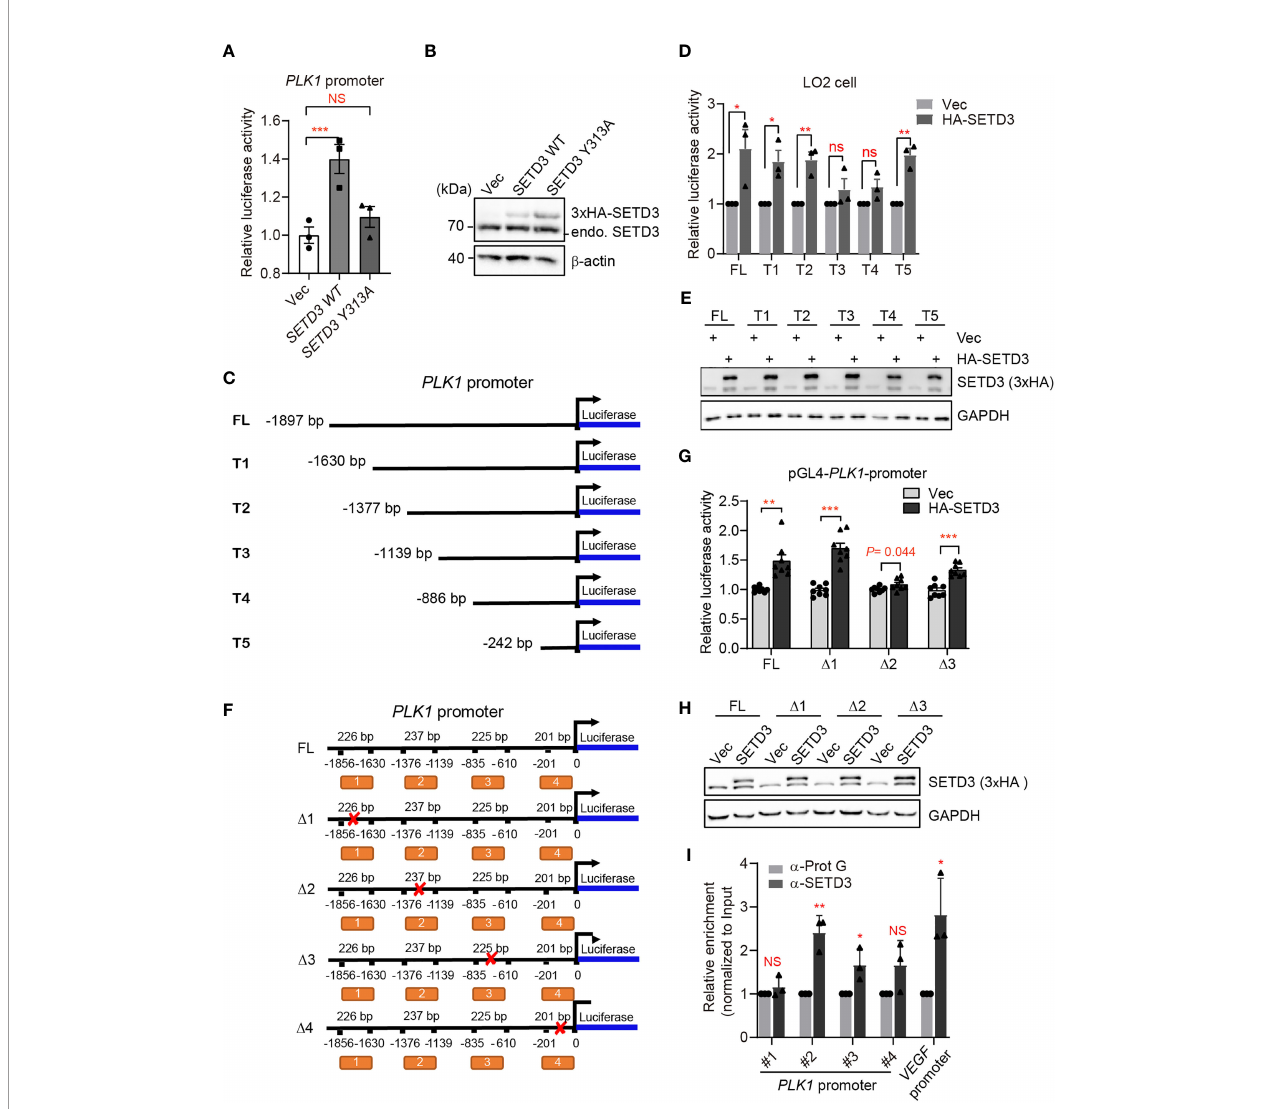
FIGURE 7 | SETD3 targets the promoter of PLK1 gene to regulate its expression. (A) Dual-luciferase assays were performed using the indicated SETD3 constructs, which were co-transfected with a luciferase reporter containing PLK1 promoter and a Renilla construct. Relative luciferase activity was measured by quantitative PCR. (B) SETD3 protein levels expressed in panel (A) were examined using Western blotting. (C, F) The diagram shows the indicated constructs used in panel (D) or (G) , respectively. (D, G) Dual-luciferase assays were performed using the indicated luciferase reporter constructs bearing different PLK1 -promoter regions co- transfected with SETD3 and Renilla constructs. (E, H) SETD3 protein levels expressed in panel (D) or (G) were examined using Western blotting, respectively. (I) ChIP-qPCR analyses were performed to examine the association of SETD3 with the indicated regions of PLK1 promoter. The binding of SETD3 with the VEGF promoter served as a positive control. The relative enrichment of SETD3 was normalized to input and relative to the association of protein G beads. Data are presented as mean ± SD. NS, not signi fi cant; * p < 0.05; ** p < 0.01; *** p <